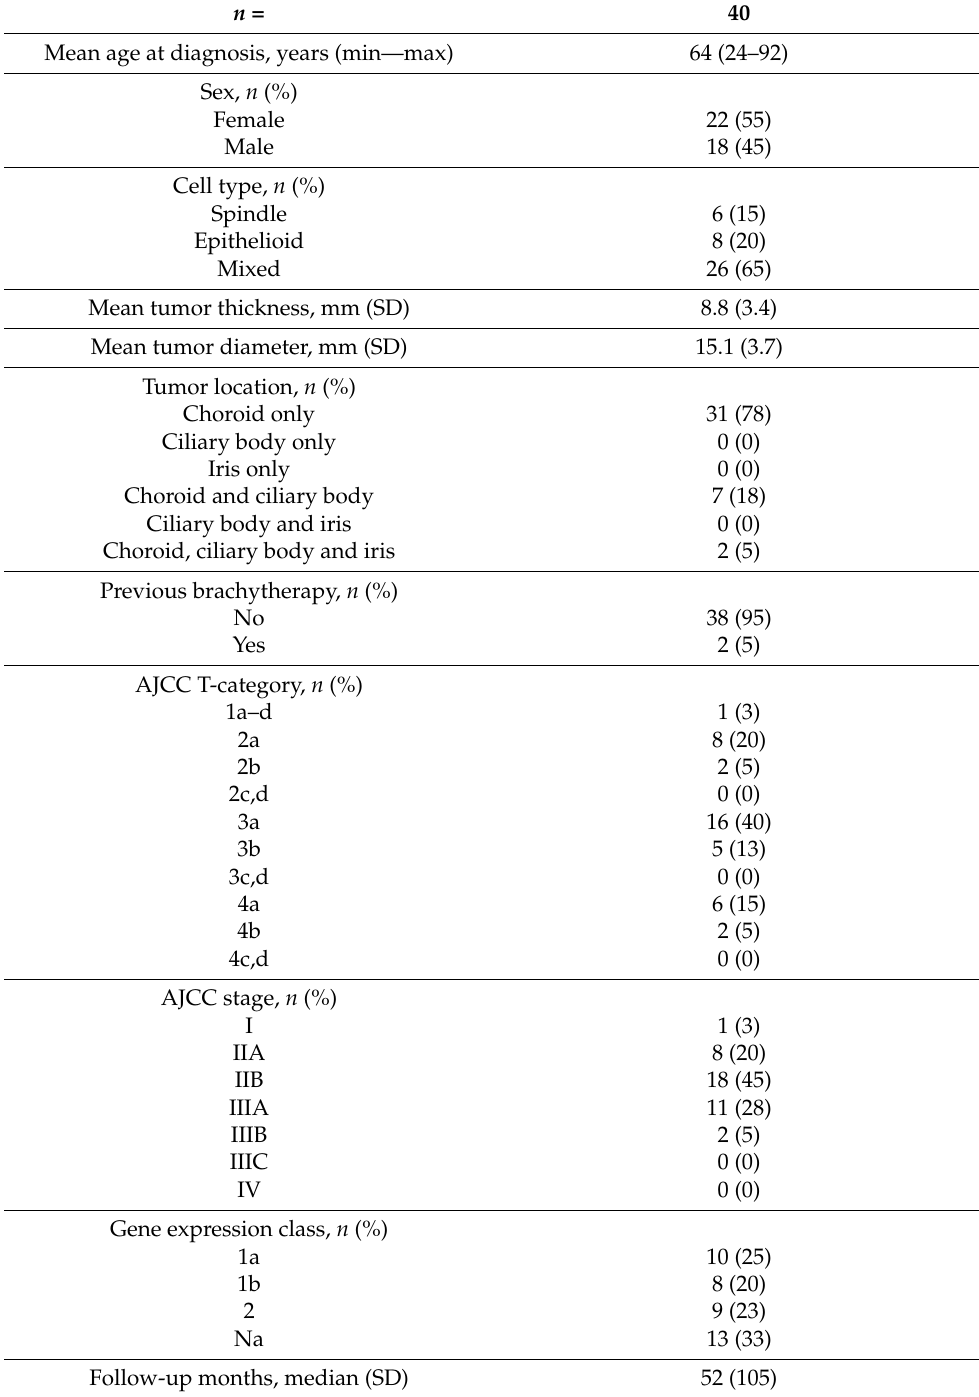
Table 1. Demographics and clinical features of study patients and